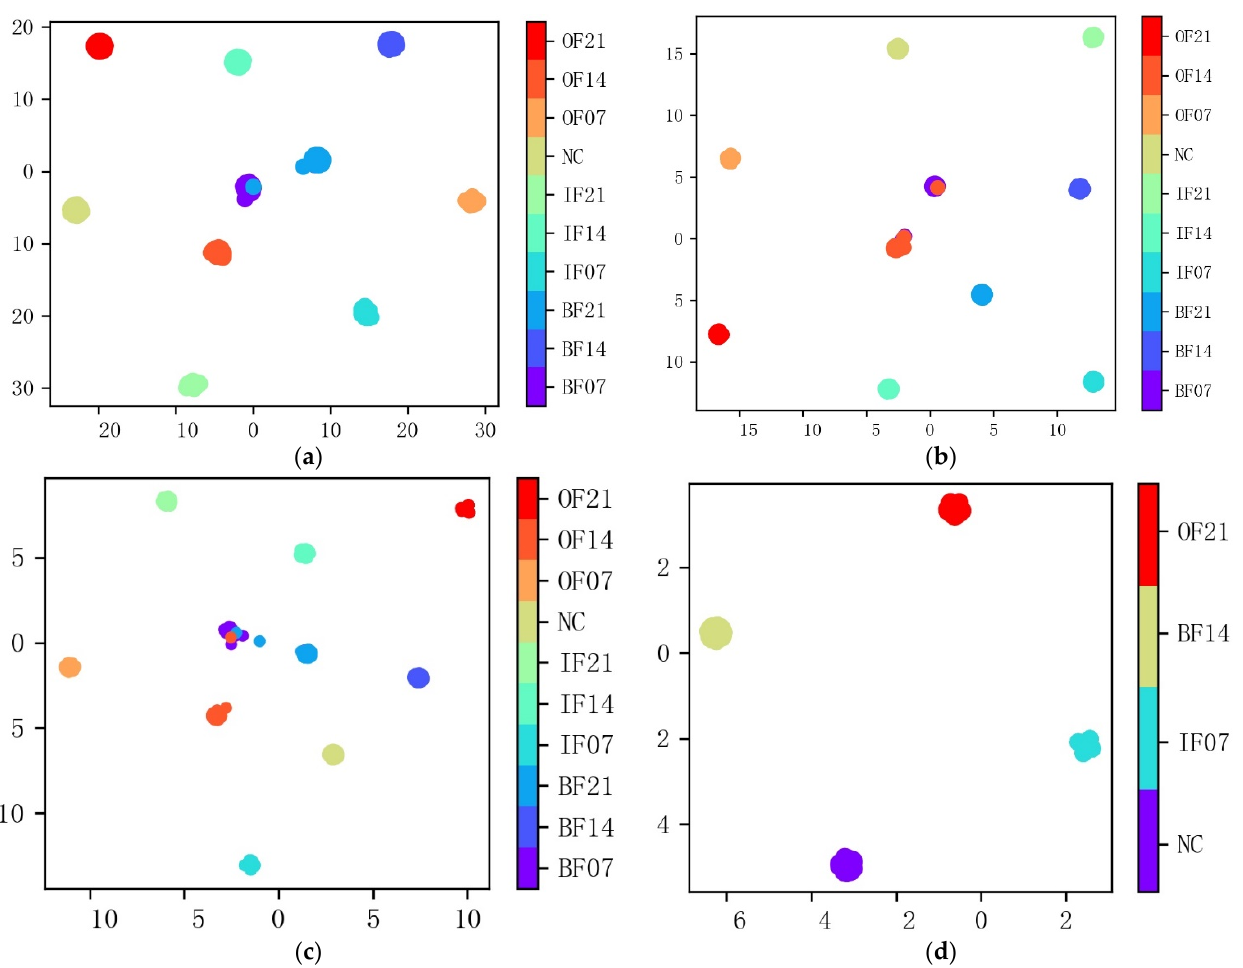
Figure 8. Feature visualization by t-SNE for each dataset: ( a ) Dataset A; ( b ) Dataset B; ( c ) Dataset C; ( d ) Dataset D.